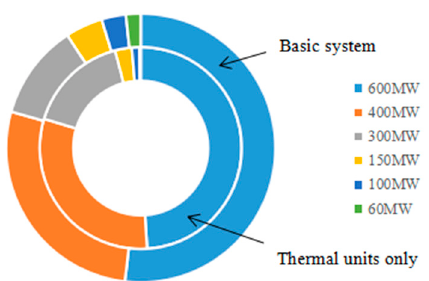
Figure 6. The comparative results between thermal-only units and the basic system.